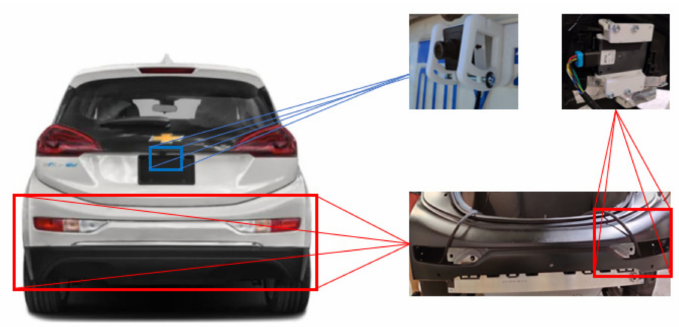
Figure 2. Hardware setup for the RCT detection system. The radar system consists of two rearward-looking single beam mono-pulse radars located at each corner of the vehicle to detect objects behind and to the side of the host vehicle. Each radar can cover 180 ◦ FOV horizontally. The left and right radars have some overlapped FOV and the combined radar system has 300 ◦ FOV, as shown in Figure 3a. One radar is a right-handed radar and the other one is a left-handed radar. Further, the two radars need to be installed with an angle of 30 degrees (+30 yaw of the vehicle travel direction), as presented in Figure